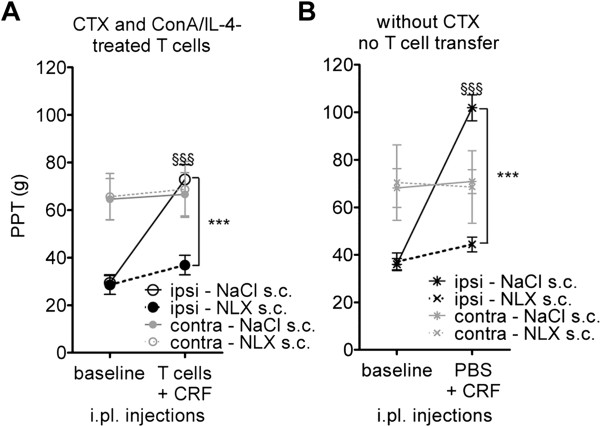
CRF-induced antinociception in recipients of activated, ConA/IL-4-stimulated T cells is opioid mediated.A) NLX reversibility of CRF-induced antinociception in CTX-treated recipients of T cells stimulated with ConA/IL-4. PPT were determined at baseline and after i.pl. injections of T cells and CRF. Controls received s.c. NaCl. B) CRF-induced antinociception and NLX-reversibility in non-immunosuppressed rats. PPT were determined at baseline and after CRF injection. Data represent means ± SD (n = 7–8 animals per group). Effects of the injection (baseline versus CRF) and of the treatment (saline versus NLX) on ipsilateral PPT were analyzed using Two-Way RM ANOVA and Bonferroni’s Test. §§§, CRF injection significantly elevated PPT in NaCl-treated animals (P < 0.001); ***, CRF-induced elevation of PPT is significantly reduced by NLX (P < 0.001).